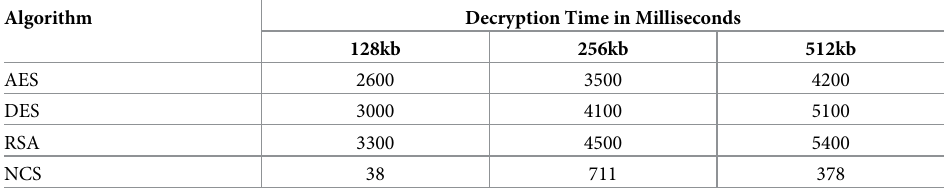
Table 6. Comparing the decryption Time of the proposed (NCS) algorithm with conventional algorithms using different key